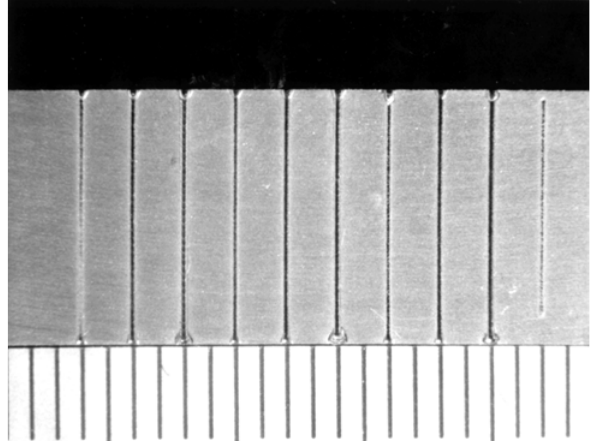
Figure 1. Laser welding on the aluminum surface (milimetric di-